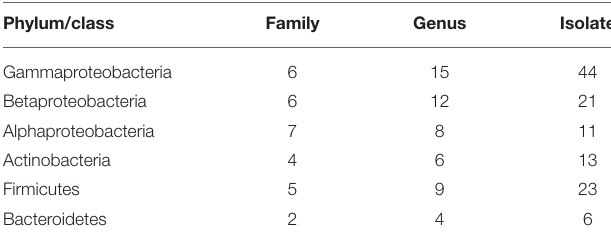
TABLE 1 | The taxonomic distribution of bacterial isolates.